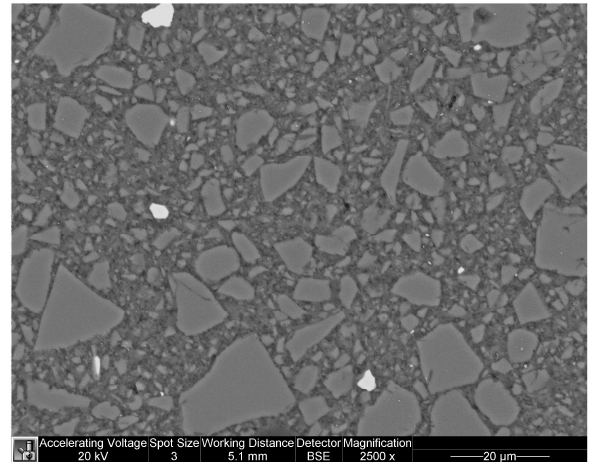
Figure 6. Polished section SEM micrograph showing a typical microstructure for reacted powder sample R0812. A (magnesite) cement phase closely surrounds the (relatively fine) olivine grains, resulting in a very low sample porosity.